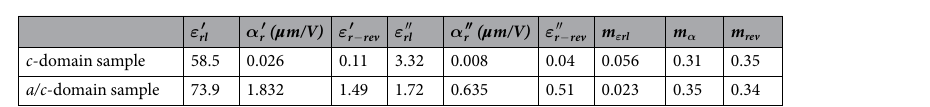
Table 1. Coefficient of the lattice, domain wall pinning and domain vibration contributions for the real and the imaginary part of the total permittivity and the dissipation factors of the different